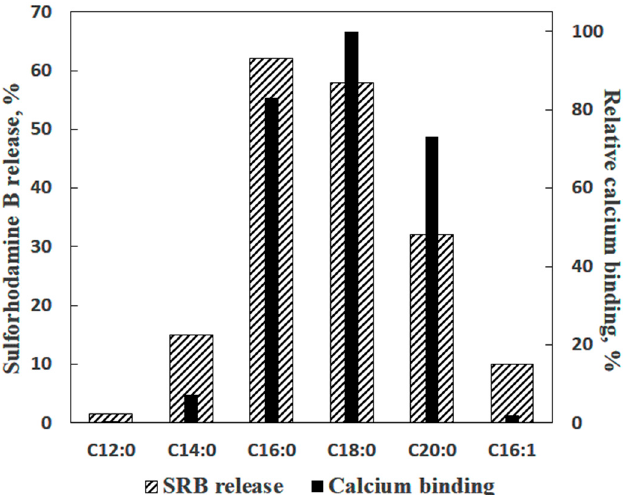
Figure 2. Ca 2+ -induced permeabilization of lecithin liposomes containing various fatty acids in comparison with the ability of fatty acids to bind Ca 2+ ions. The data on the Ca 2+ -binding ability of fatty acids were taken from Table 1. Additions: 30 µM of a fatty acid and 1 mM Ca 2+ . The media contained 10 mM Tris-HCl (pH 8.5), 50 µ M EGTA (ethylene glycol-bis( β -aminoethyl ether)- N , N , N ′ , N ′ -tetraacetic acid), and 40 µM KCl ( n = 4).